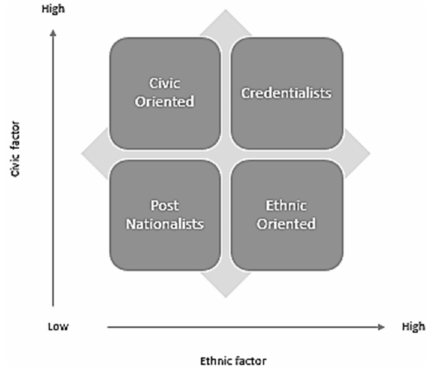
Figure 2. Apostle model applied to national